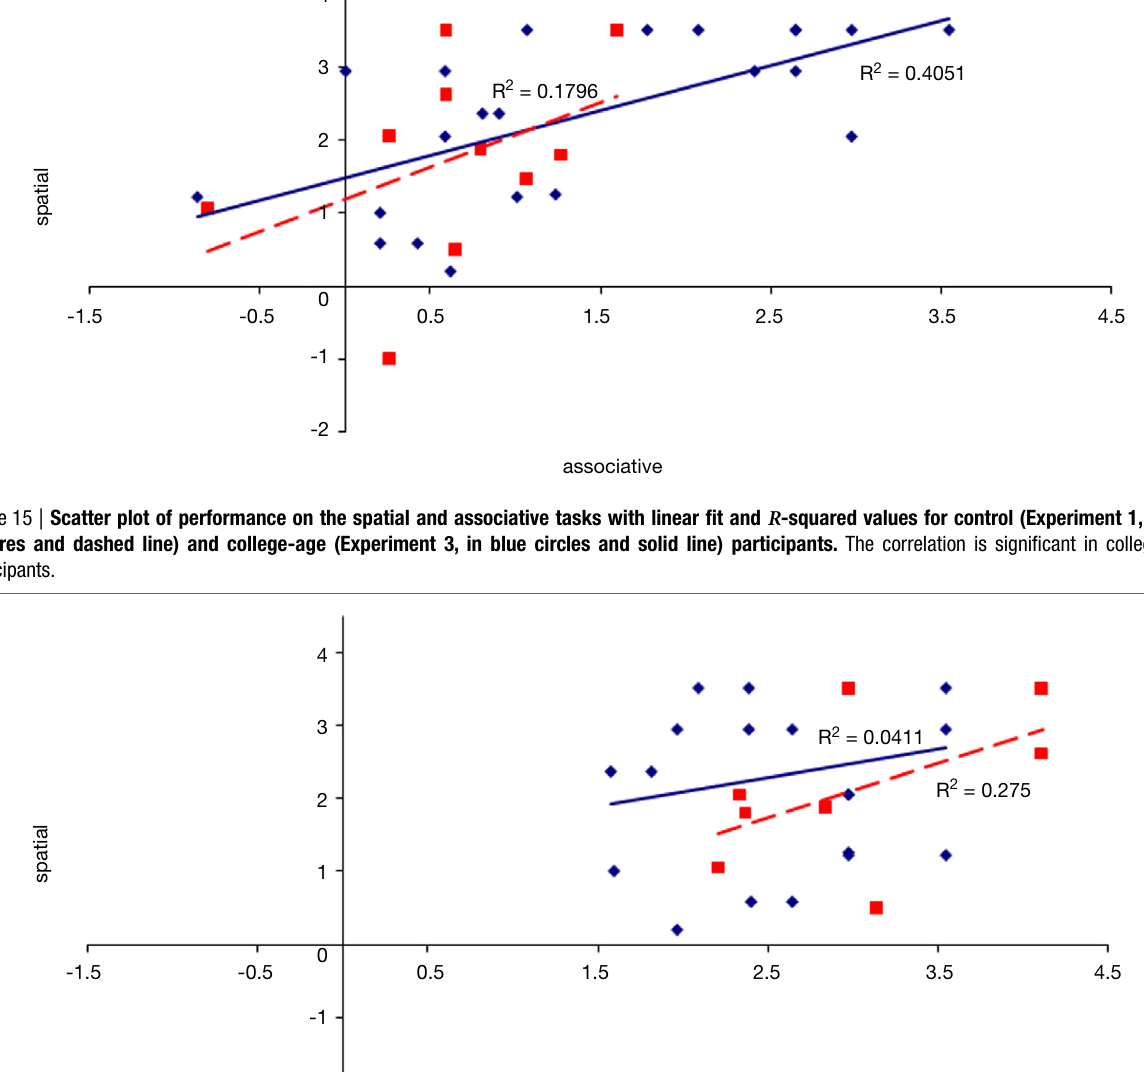
participants from Experiment 1. While the null fi nding may